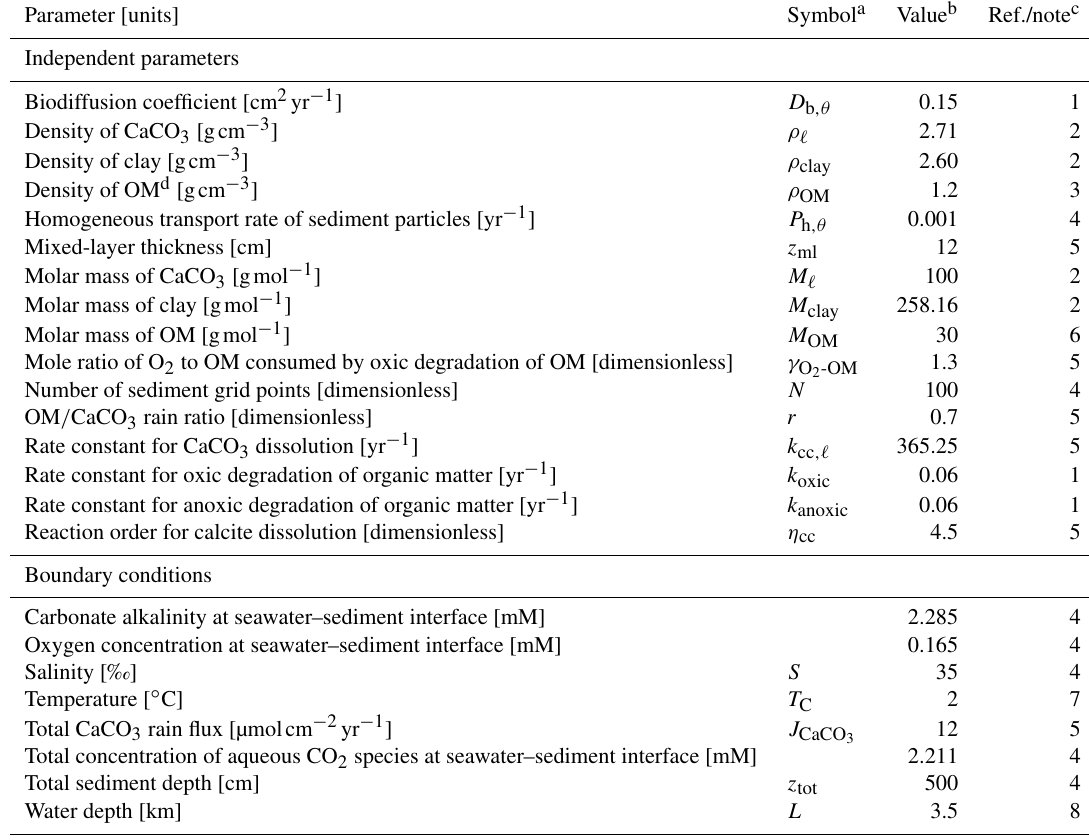
Table 1. Values of independent parameters and boundary